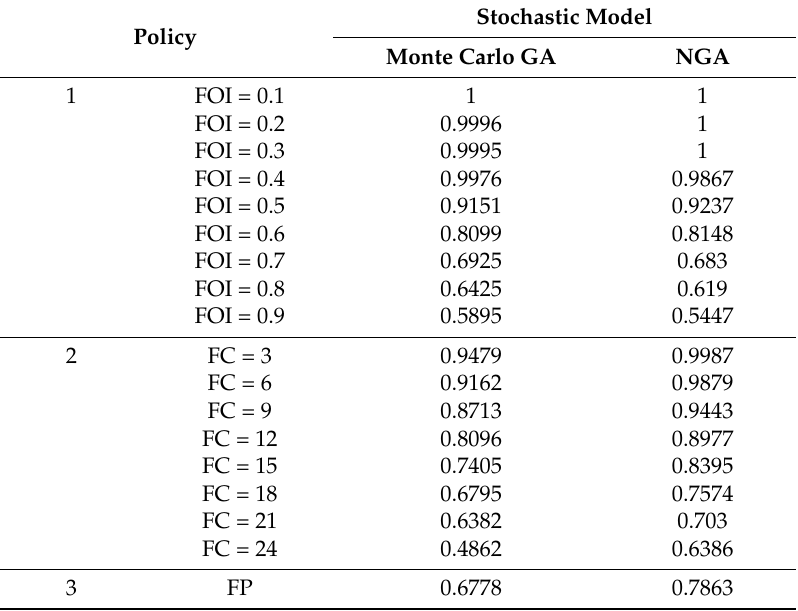
Table 4. Water supply reliability R for Monte Carlo GA and NGA